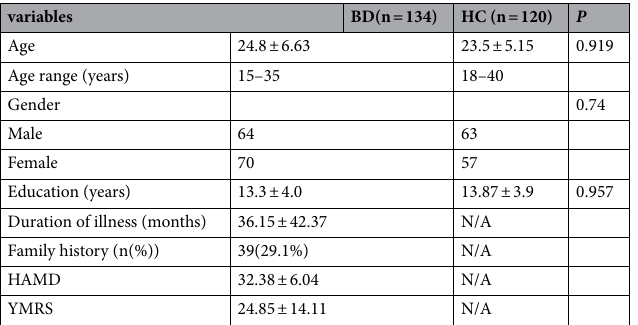
Table 1. Basic demographic and clinical characteristics of BD and healthy controls. HC healthy control, HAMD Hamilton depression rating scale, YMRS Young manic rating scale, N/A not available. P < 0.01 was considered statistically